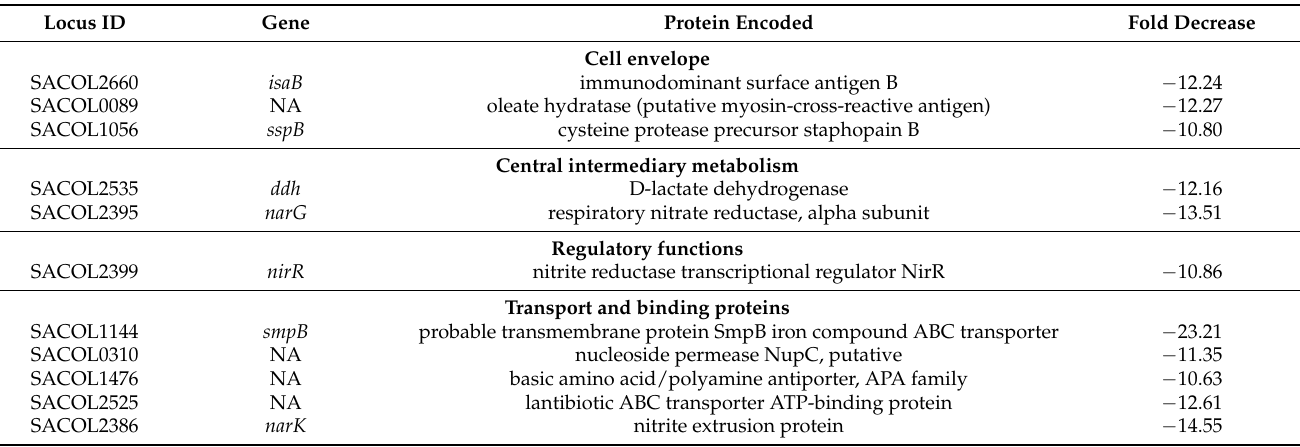
Table 5. Genes downregulated ≥ 10-fold in SH10001st-2 compared to SH1000. Locus